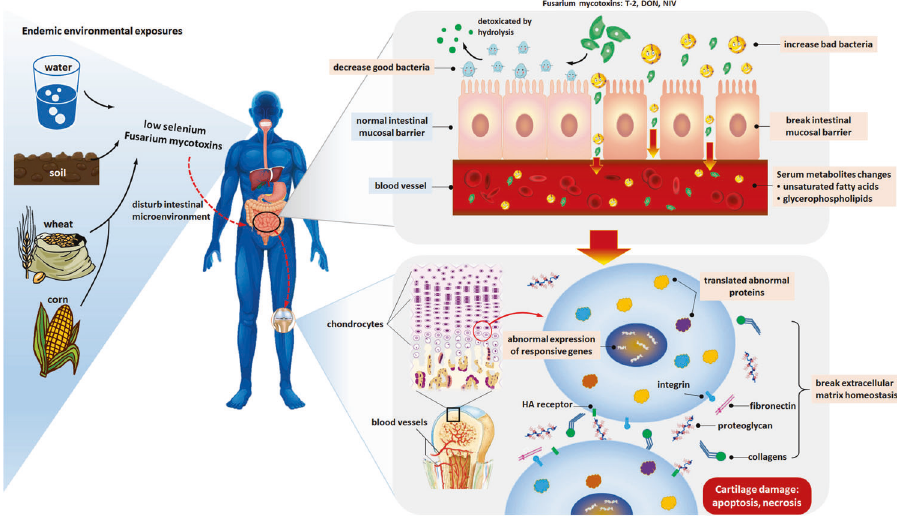
the endemic environmental risk factors, masked Fusarium mycotoxins, enter the human body. Due to abnormal alteration of the gut microbiota caused by selenium de fi ciency, the ef fi ciency of the hydrolysis of masked Fusarium mycotoxins by the intestinal tract is abnormal,